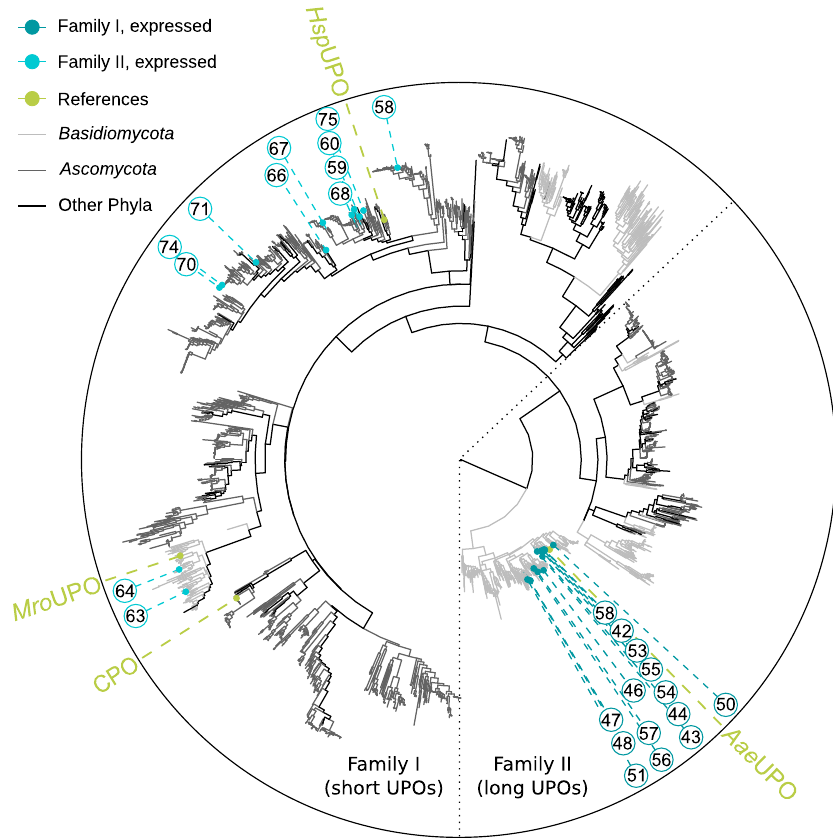
Figure 1. Maximum likelihood phylogenetic tree of all UPOs in the 3DM database. Previously characterized UPOs are marked in green. Expressed family II and family I UPOs are marked with dark blue and bright blue dots and their numbers, respectively. Clades belonging to family I and family II UPOs are separated by a dotted line. The most abundant phyla Ascomycota and Basidiomycota are shown in dark grey and light grey, respectively.